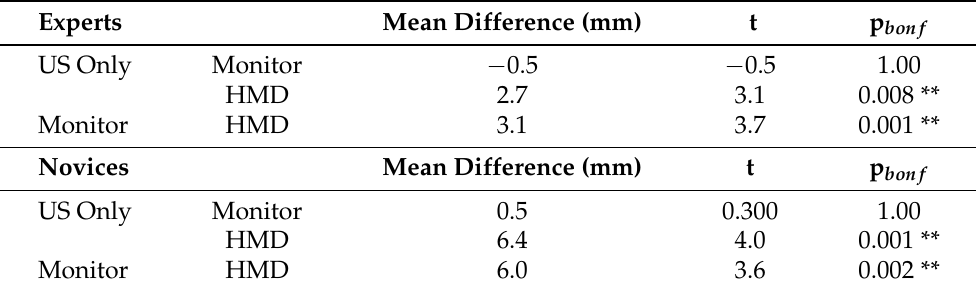
Table 1. Post-hoc test results following repeated measures ANOVA analysis for the distance from the final needle tip position to the closest point on the center line of the vessel for both experts and novices.